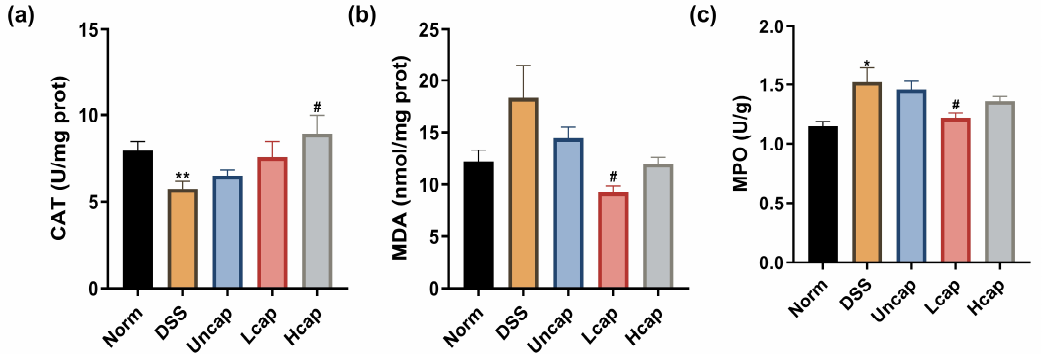
Figure 3. S. spongiosa polysaccharides improved antioxidant capacity in colitis mice. The concentrations of CAT ( a ), MDA ( b ) and MPO ( c ) were estimated by ELISA. The values are reported as means ± SD ( n = 8). * p < 0.05 and ** p < 0.01 vs. Norm group; # p < 0.05 vs. DSS group.